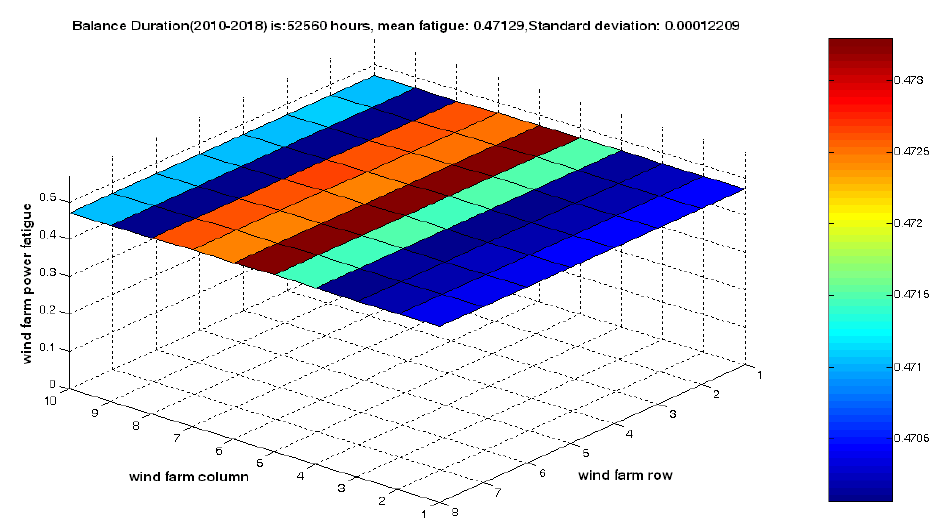
Figure 10. WT fatigue distribution based on the improved control (2010–2018, Horns Rev OWF).